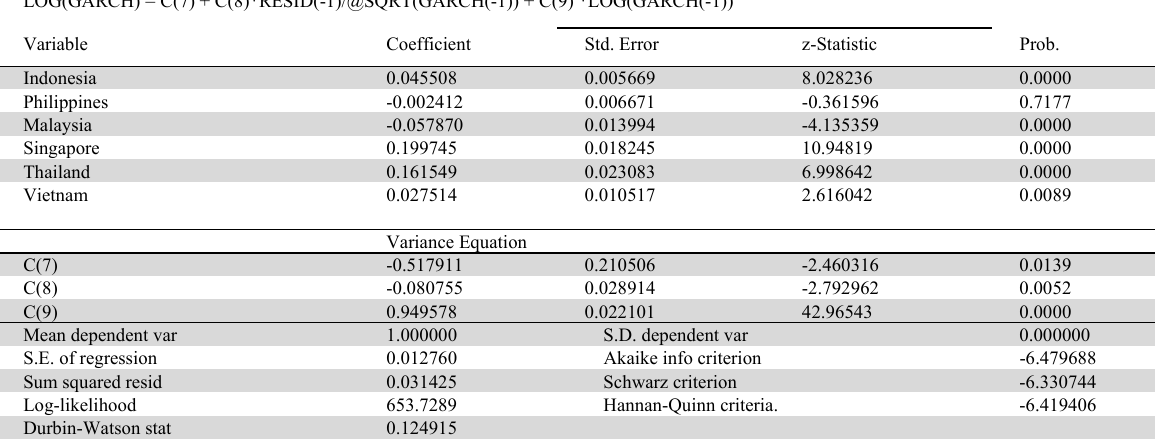
Results of the EGARC H model without considering structural damage